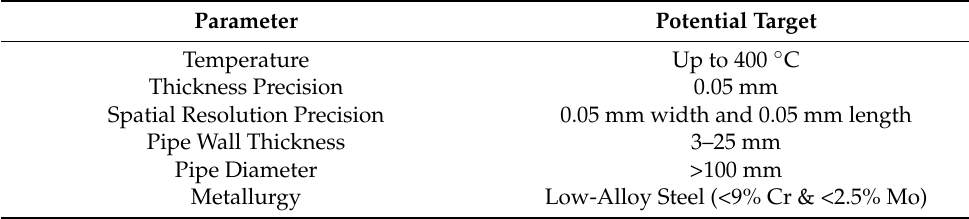
Table 1. The parameters that affect the napthenic acids